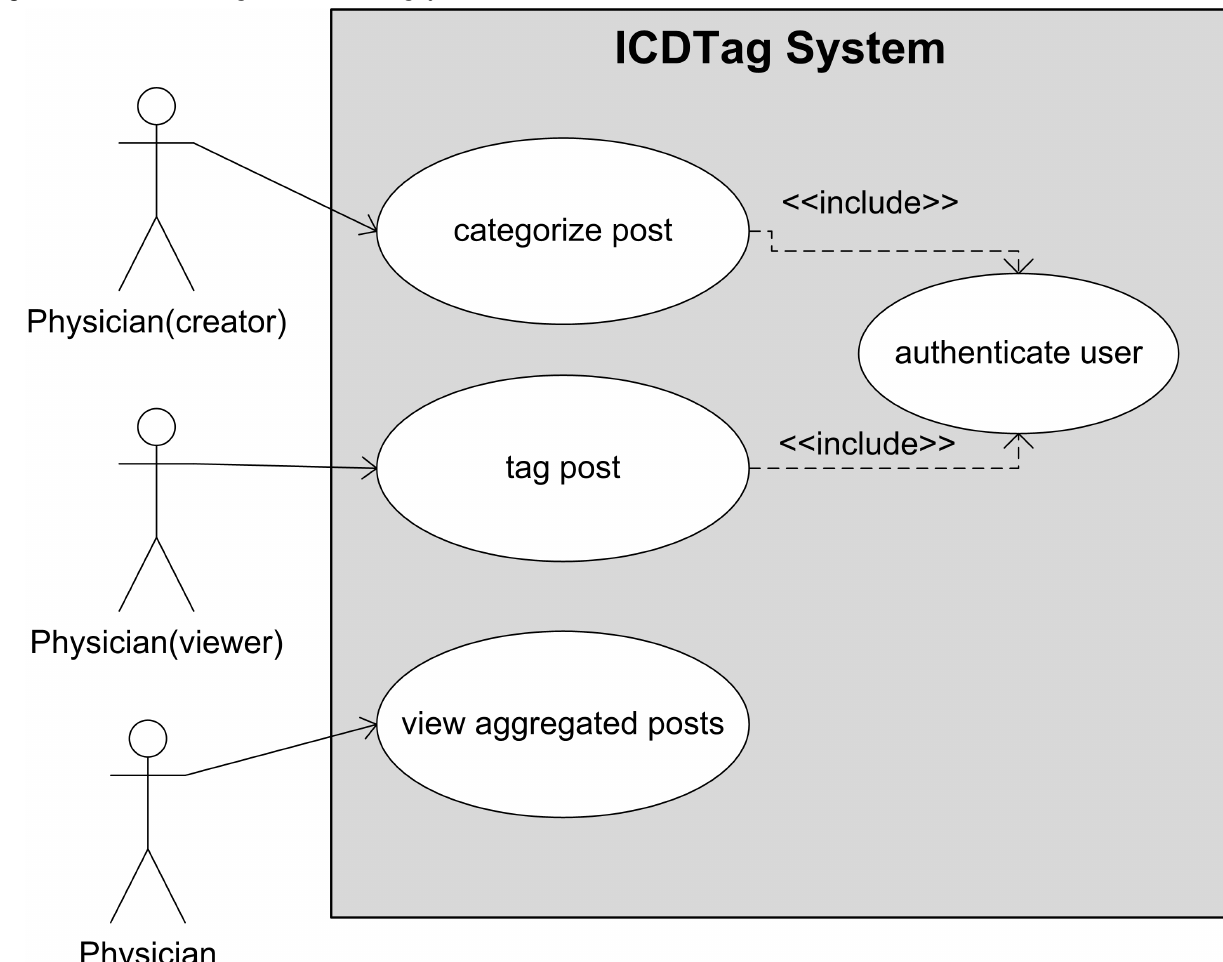
Figure 3. UML use case diagram for the ICDTag